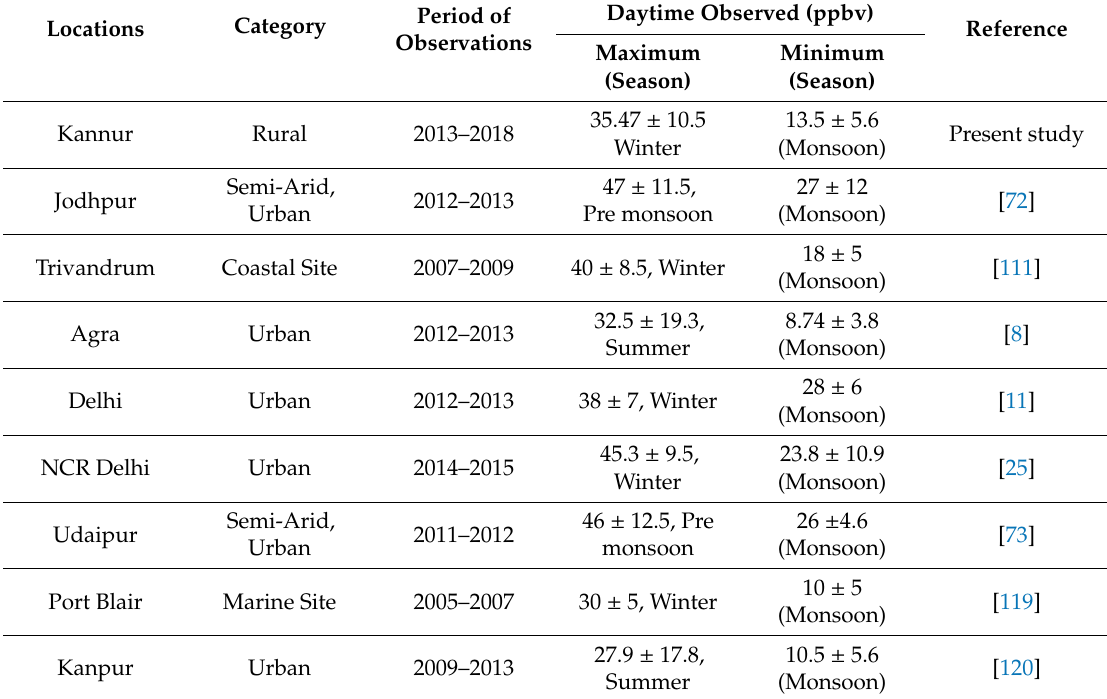
Table 6. Observed maxima and minima surface O 3 concentrations at Kannur and other locations in India for a